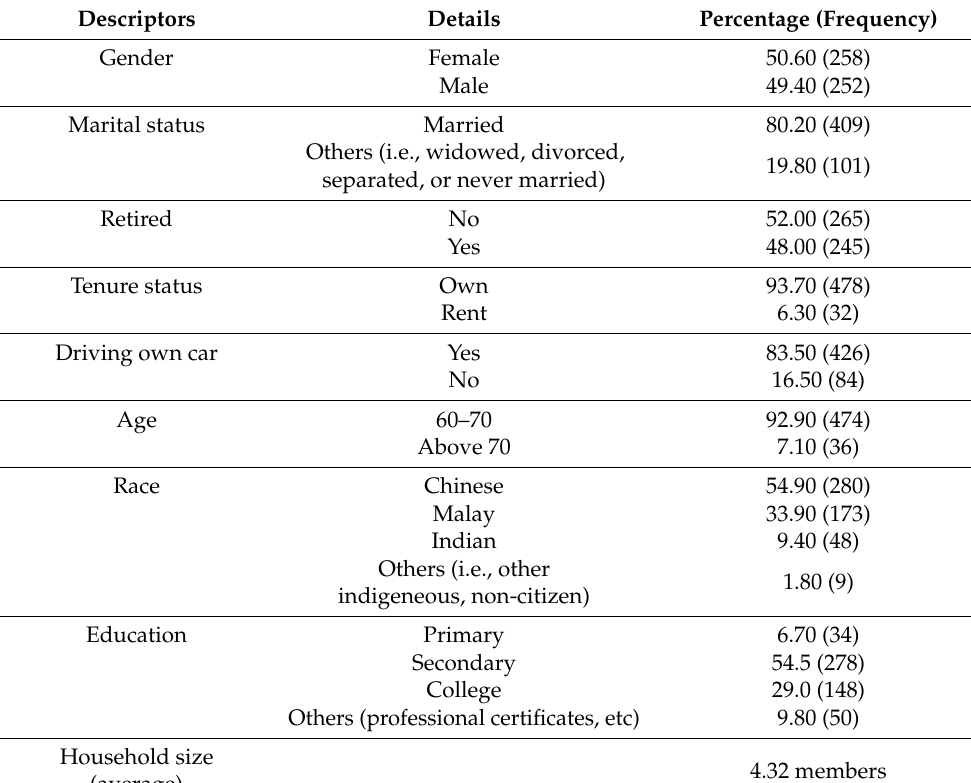
Table 2. Respondents’ demographic